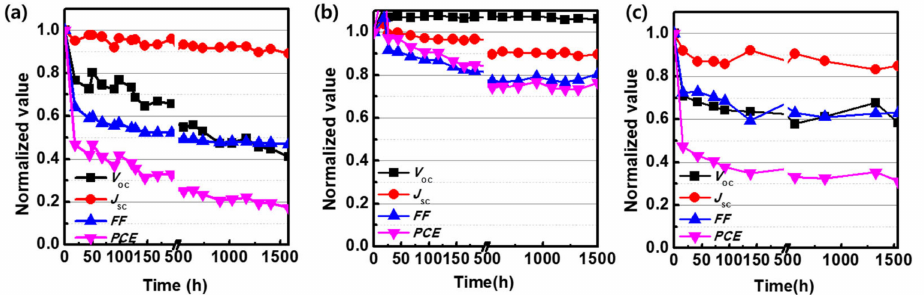
Figure 3. Changes in the solar cell parameters of ( a ) Binary, ( b ) Ternary-F, and ( c ) Ternary-CN as a function of the light-soaking time.